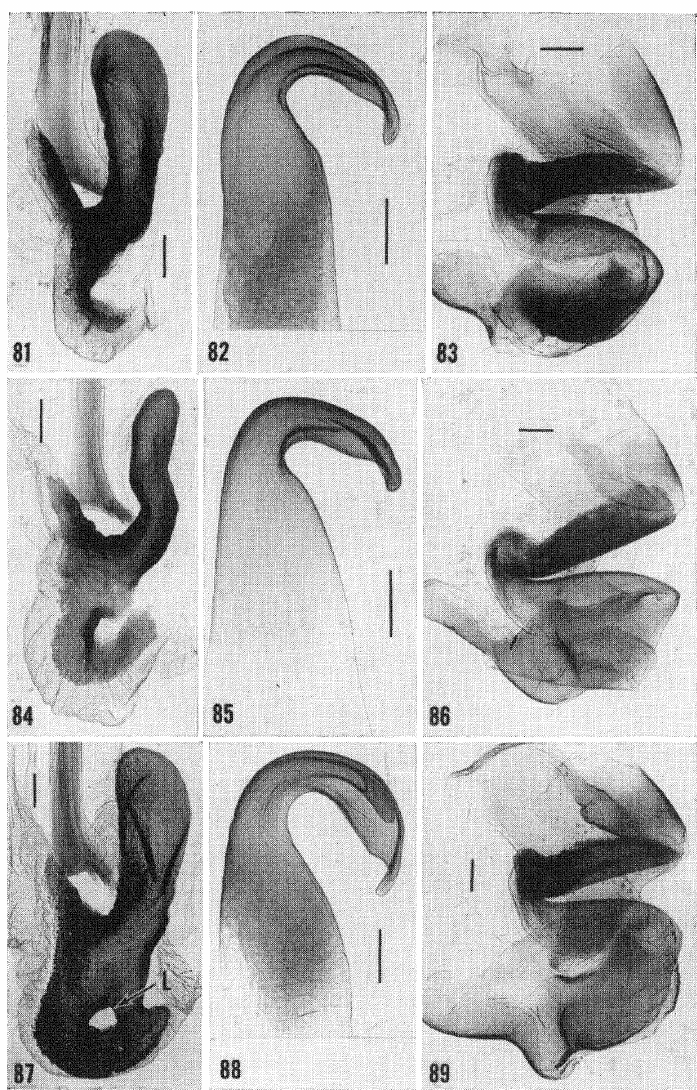
Figs. 81-89. 81-83. (100 ANSP). Phortioeca apol’inari. (from adult shown in Fig. 15). 84-86. (2 CUZM). Phortioeca eerrucosa. (from adult shown in Fig. 16). 87-89. (98 ANSP). Phortioeca loeruana. (from adalt shown in Fig. 13). L --" lacuna in selerotized basal area of L2d. (scale 0.2